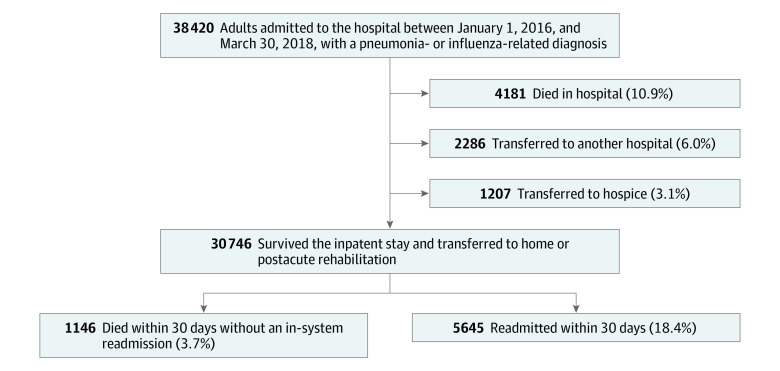
Cohort Selection